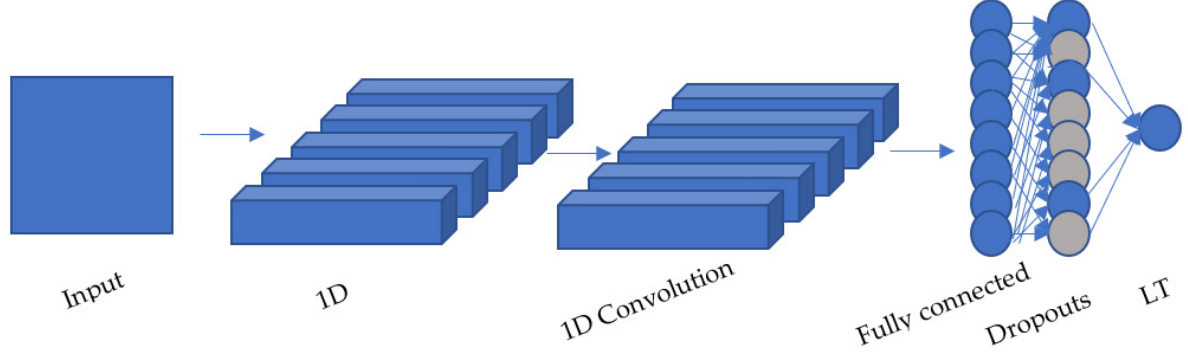
Figure A1. Base model structure.